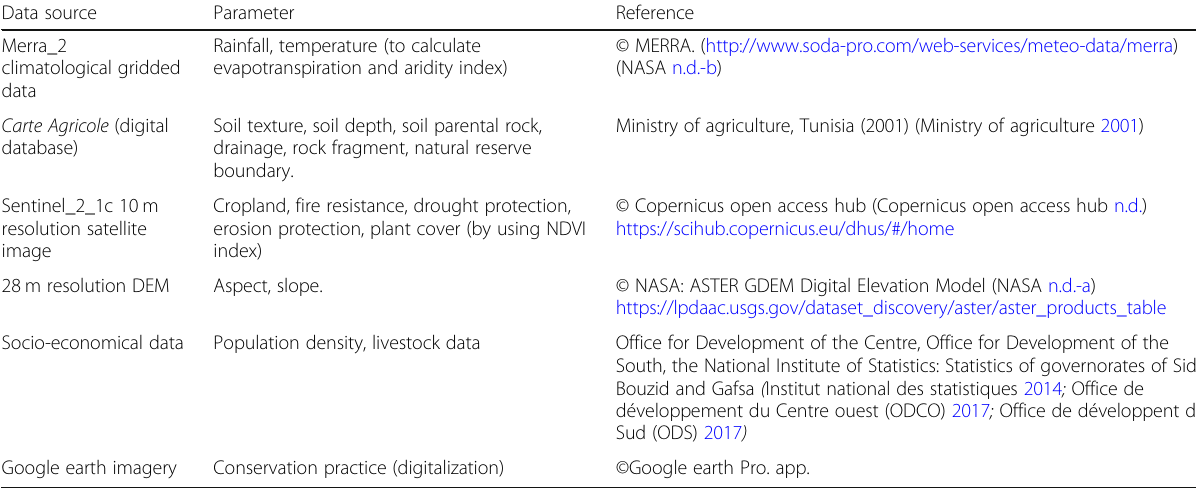
Table 2 Data sources Data source Parameter Reference